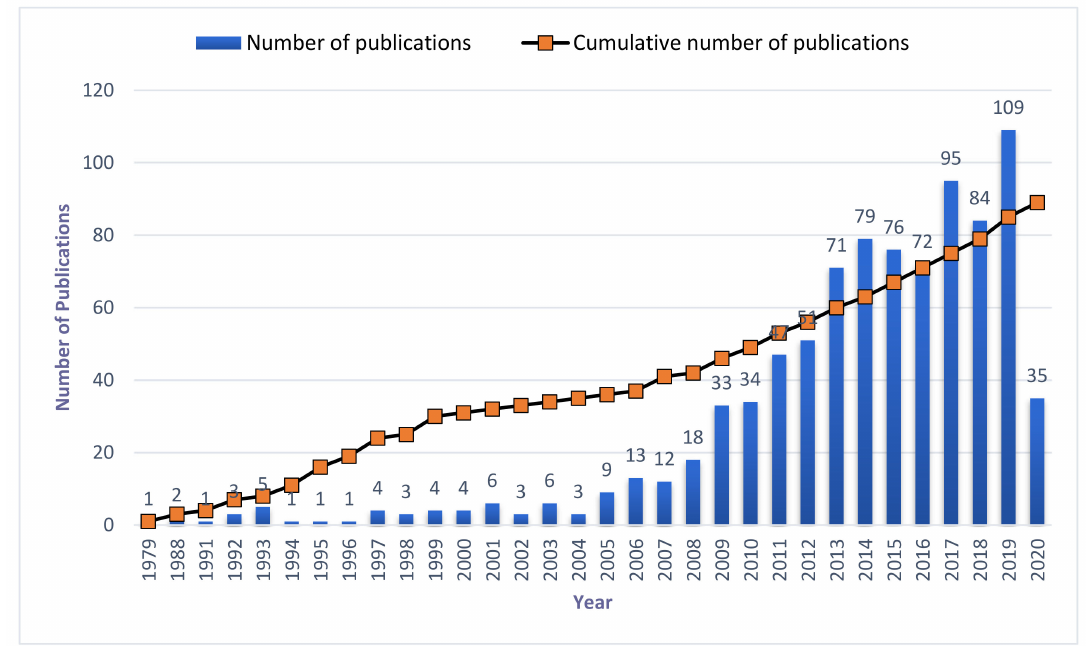
Figure 1. Distribution and cumulative publication over the years. Source. Own elaboration based on R studio output.